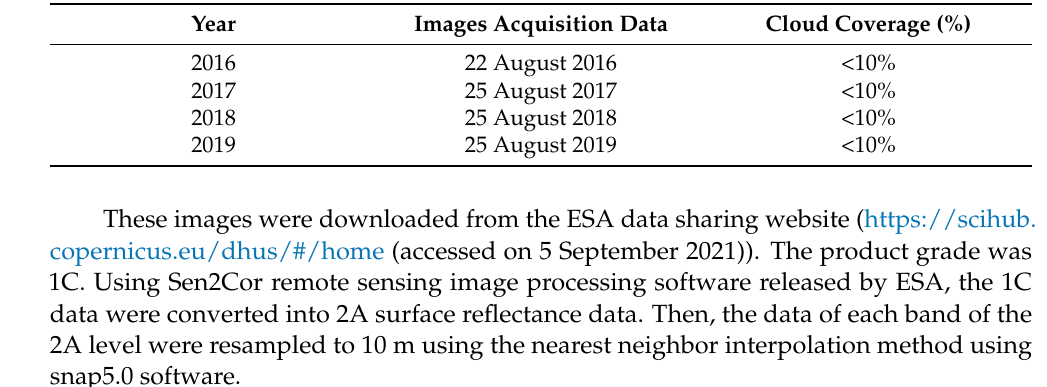
Table 1. Information about the selected satellite image.